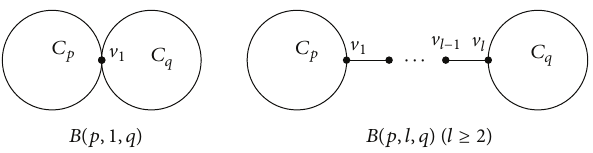
Figure 1: 𝐵(𝑝,1, 𝑞) and 𝐵(𝑝,𝑙, 𝑞) (𝑙 ≥ 2) .